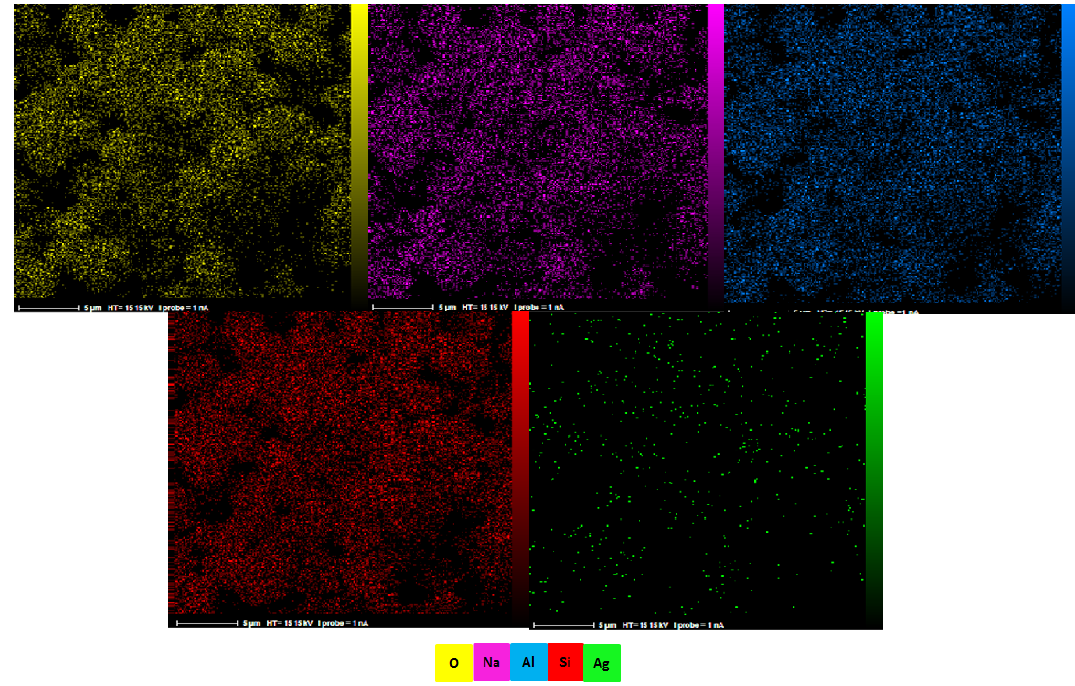
Fig. 8. Elemental mapping of the Ag NPs/Zeolite 13X nanocomposite. Fig.8 . Elemental mapping of the Ag NPs/Zeolite 13X nanocomposite.